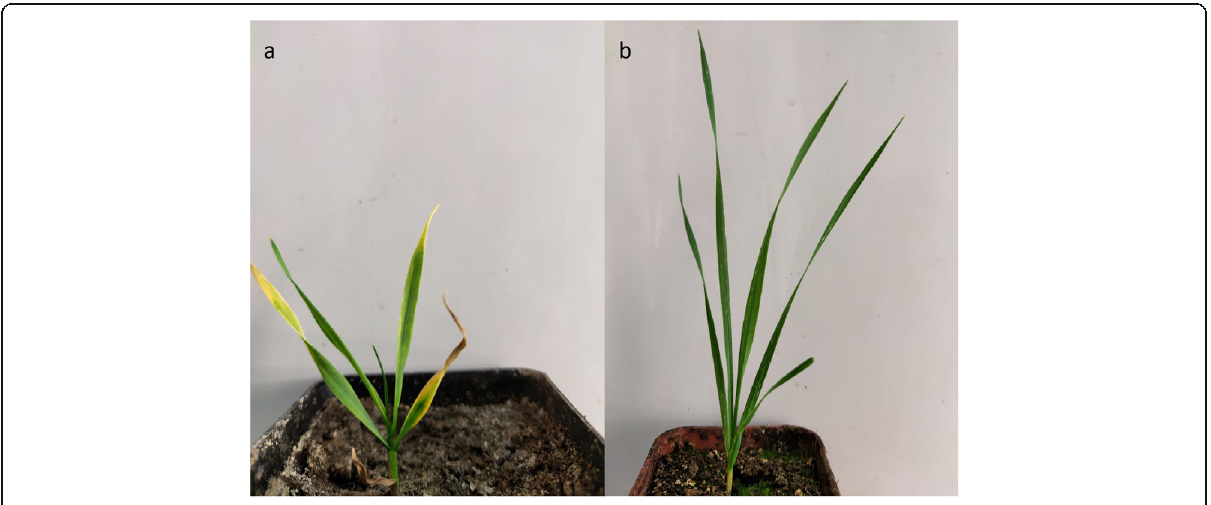
Fig. 5 Disease symptoms in WDV-infected wheat plant ( a ) and mock-treated wheat plant ( b ). Photographs were taken at 20